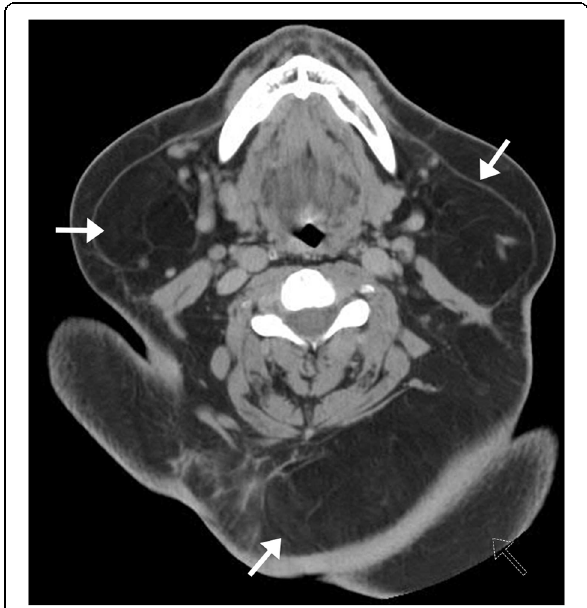
Fig. 27 Madelung disease. Axial CT image of a patient with history of alcoholism presenting with shortness of breath demonstrates diffuse symmetric unencapsulated fatty accumulation of the neck (arrows) and upper back (dashed arrow). In the given clinical context, this is most consistent with Madelung disease or benign symmetric